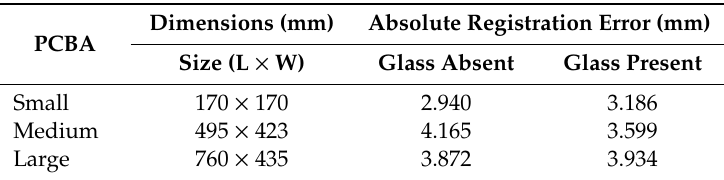
Table 4. Absolute Registration